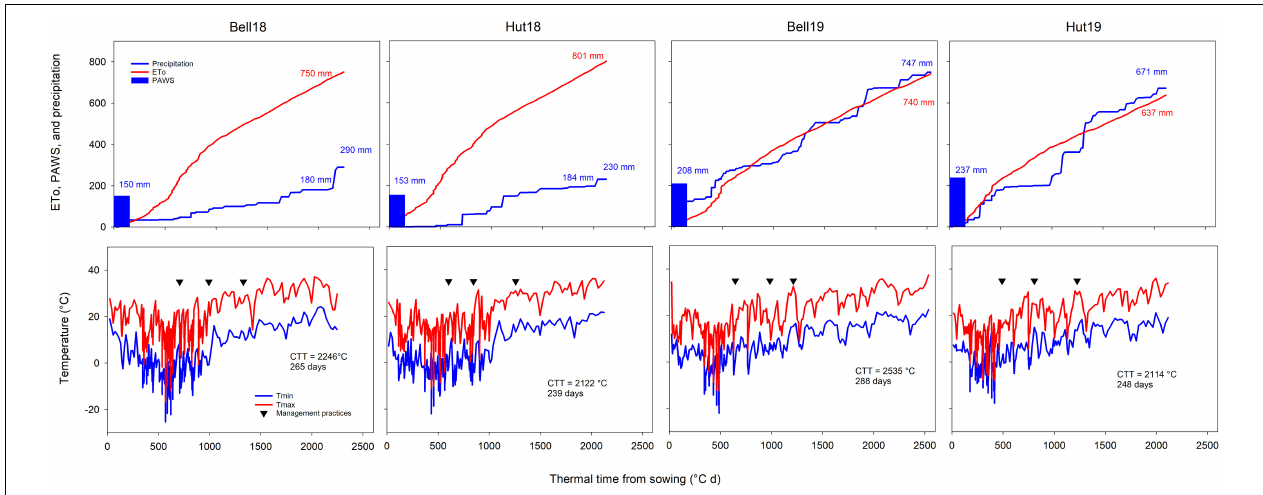
FIGURE 1 | Weather conditions experienced during the winter wheat-growing season at the four Kansas environments resulting from two locations (Bell, Belleville; Hut, Hutchinson) and two growing seasons (18, 2017–2018 season; 19, 2018–2019 season). The upper row shows plant available water at sowing (PAWS), cumulative reference evapotranspiration (ETo) and precipitation, the bottom row shows maximum and minimum temperatures. Downward facing triangles show, respectively dates for N application at Zadoks GS25, fungicide and micronutrient application at GS32, and fungicide application at GS55. Inset values show cumulative ETo, precipitation, PAWS, cumulative thermal time between sowing and harvest (CTT), and season duration in days. Two cumulative precipitation values are shown for 2018 environments as considerable rainfall occurred after the crop was mature.